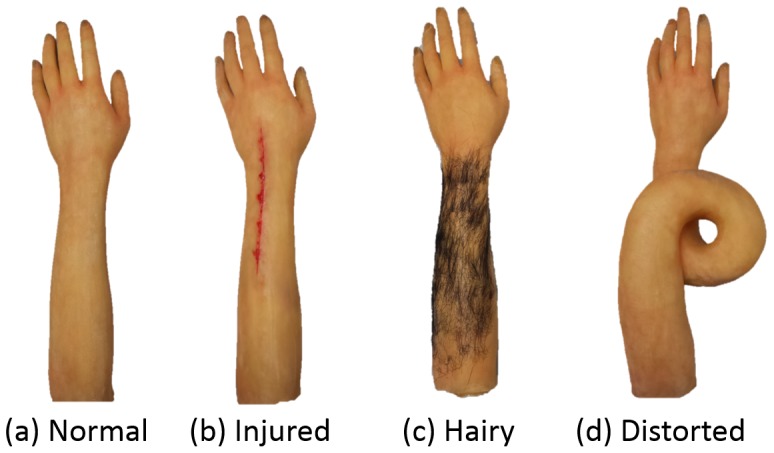
Rubber hands used in the experiments.We used 4 rubber hands that represented the following conditions: (a) did not evoke a negative body image, (b) evoked a pain-related negative body image, (c) evoked a negative body image due to non-conformance of a socially accepted appearance, and (d) evoked a negative body image due to non-conformance of the concept of a normal body.